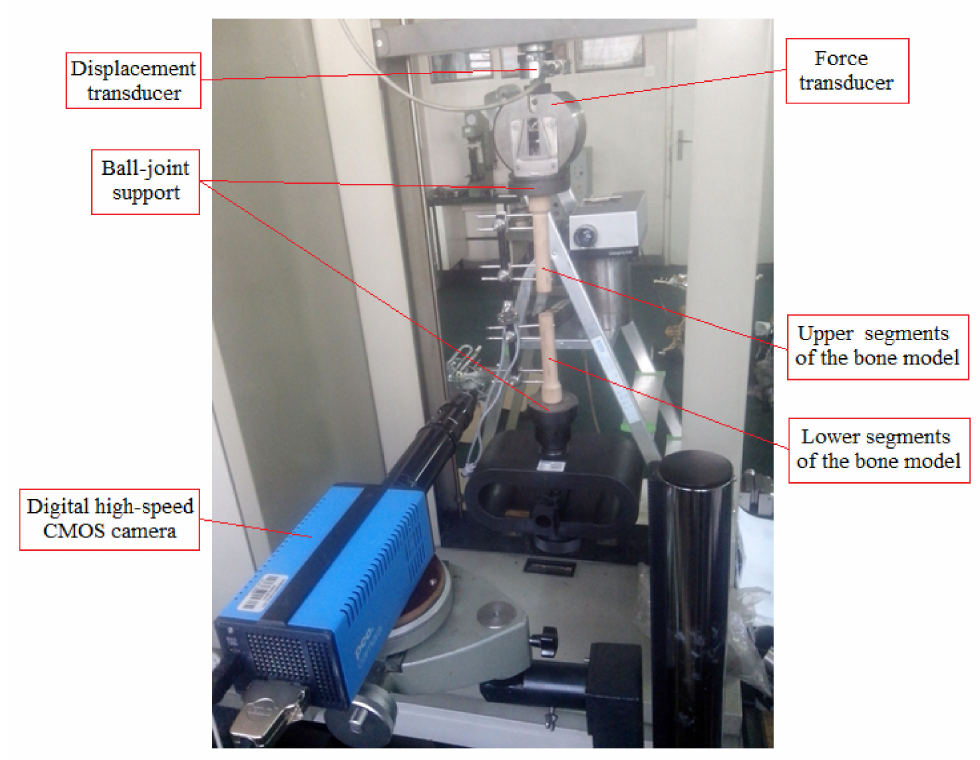
Figure 6. Experimental